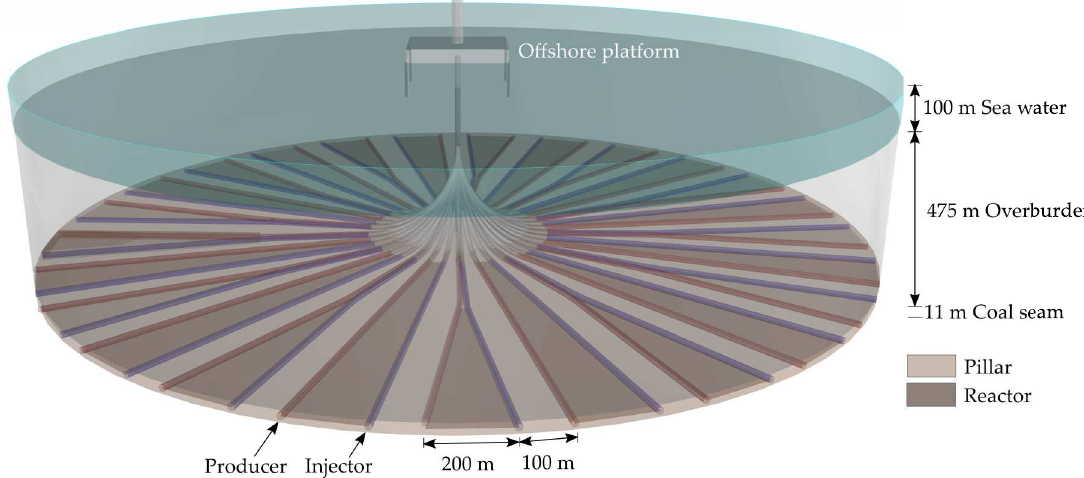
Figure 6. Computer-aided design model visualizing the proposed parallel controlled retracting injection point underground coal gasification offshore well design with twelve “long” and 13 “short” channel systems. Figure copyright [36] (modified), licensed under CC BY-NC-ND 4.0.